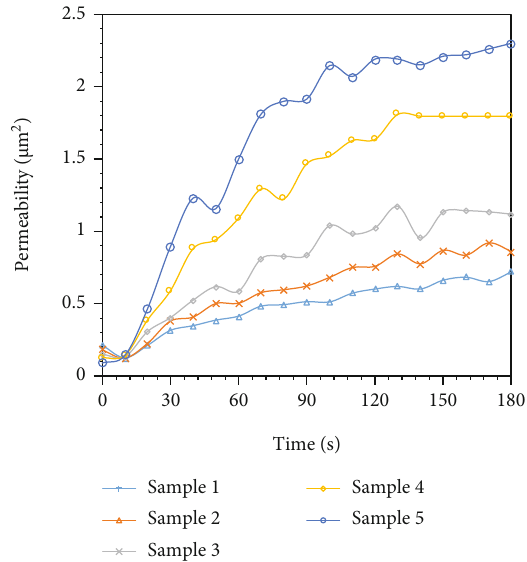
Figure 9: Evolution of sample permeability during the erosion